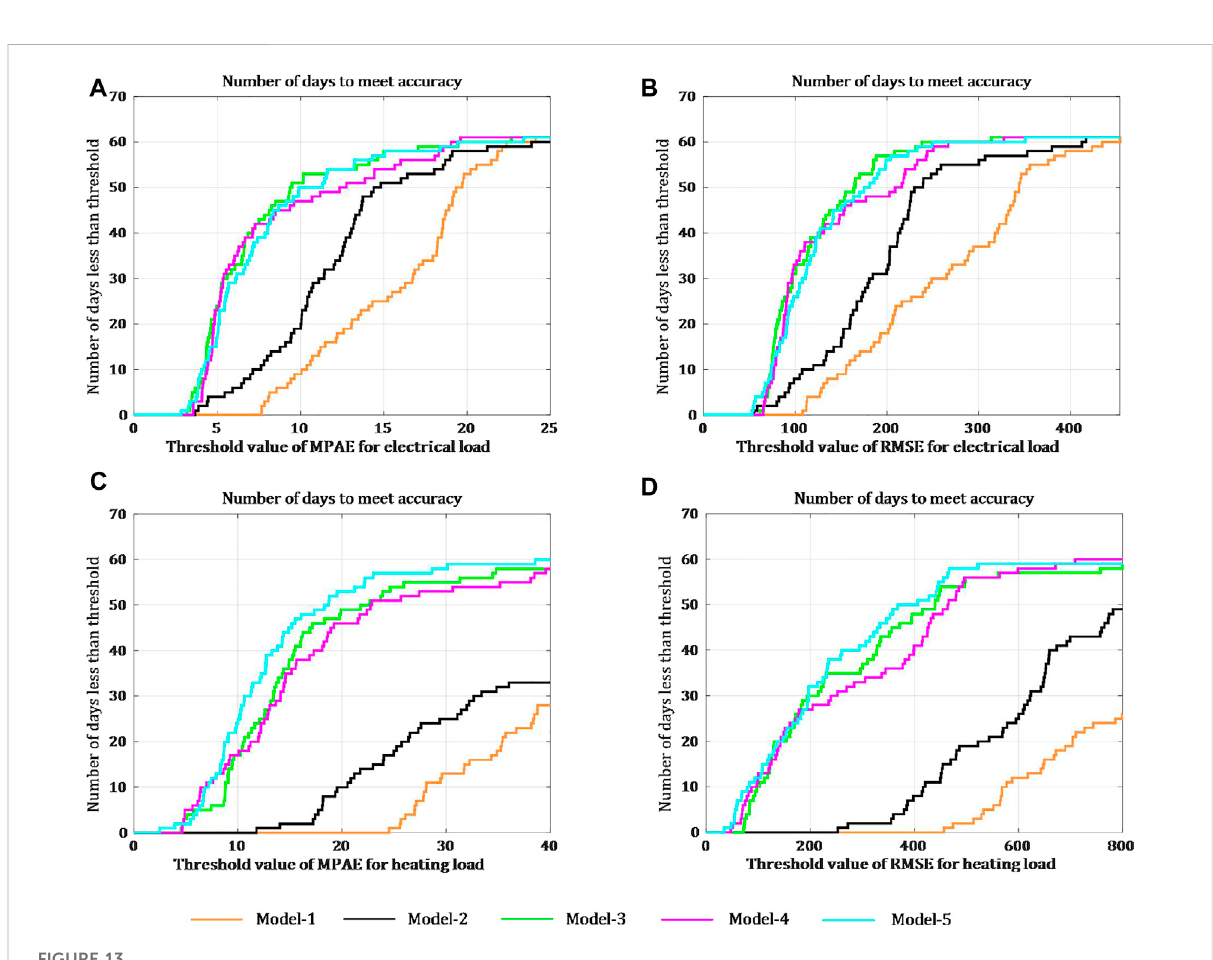
FIGURE 13 Distribution of the number of days to meet different